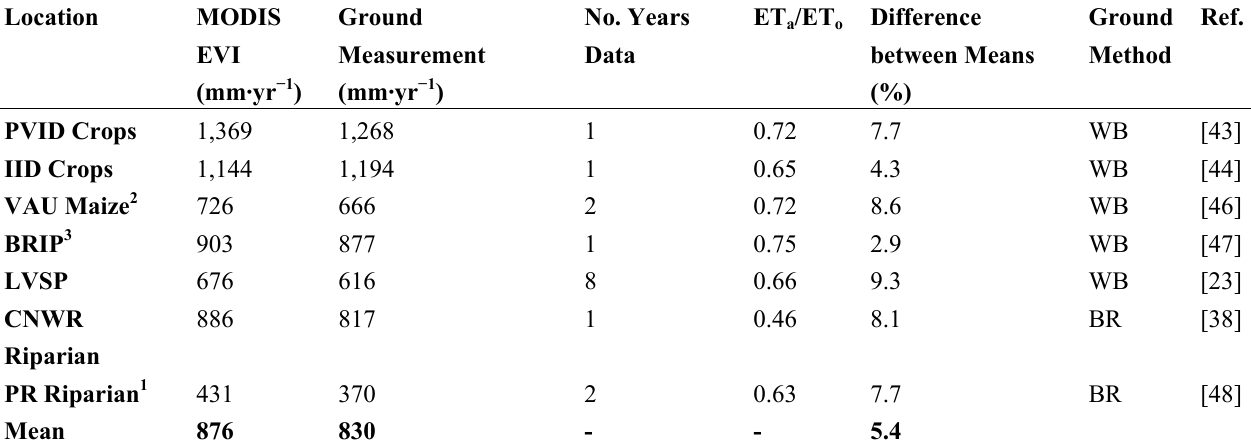
Table 1. Comparison of MODIS EVI estimates of 2008 ET PVID = Palo Verde Irrigation District, CA; IID = Imperial Irrigation District, CA; VAU = Victoria, Australia; BRID = Bear River Irrigation District, UT; LVSP = La Violada Irrigation District, Spain; CNWR = Cibola National Wildlife Refuge, CA; PR = Platte River,